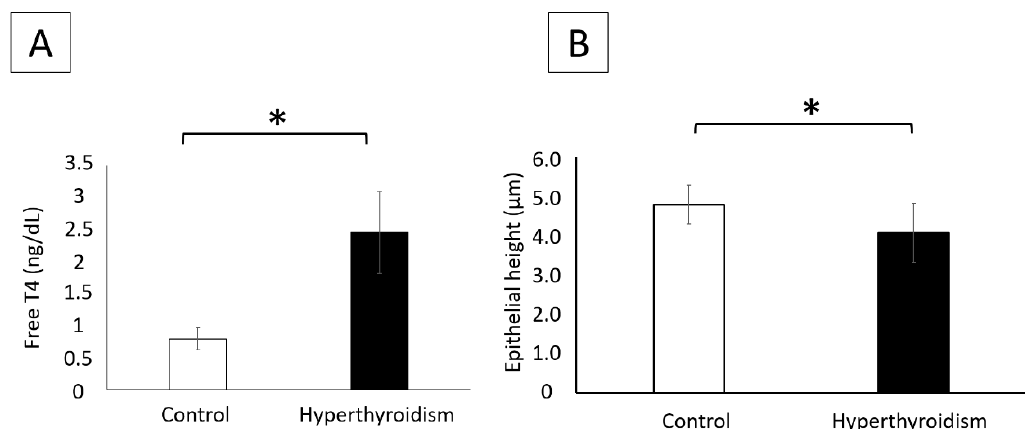
Figure 1. ( A ) Free-T4 plasma concentrations (mean ± standard deviation) of mothers in the control and hyperthyroidism groups. ( B ) Height of the follicular epithelium (μm) of the thyroid (mean ± standard deviation) of control neonates and those exposed to maternal hyperthyroidism * p < 0.05.